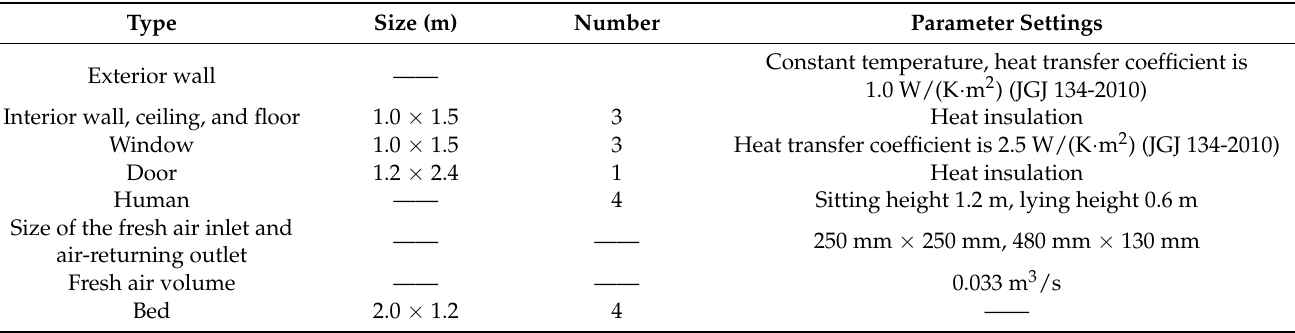
Table 2. Bedroom parameters and boundary conditions.